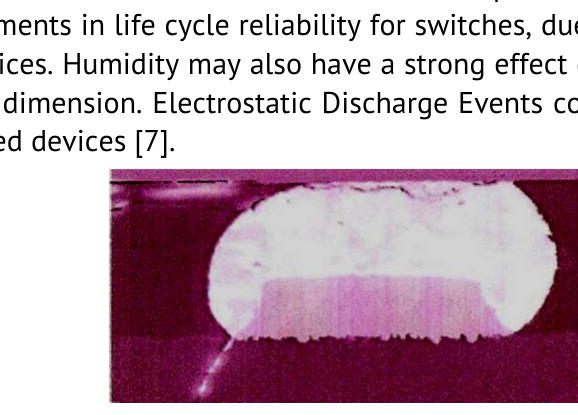
Figure 1. Example of nanocomponents intended to be integrated in a System-on- Chips (SoC).